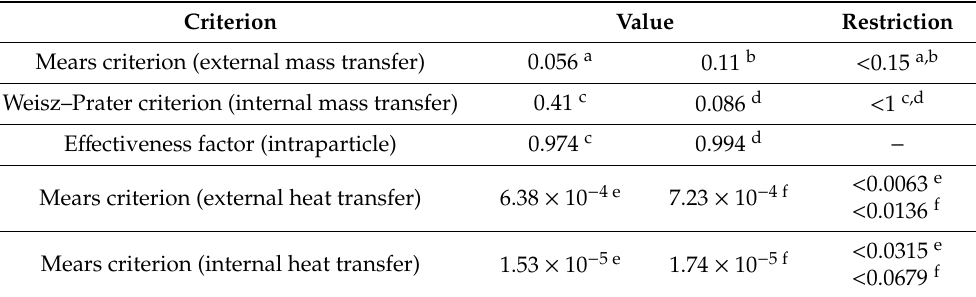
Table 3. Results of mass and heat transfer